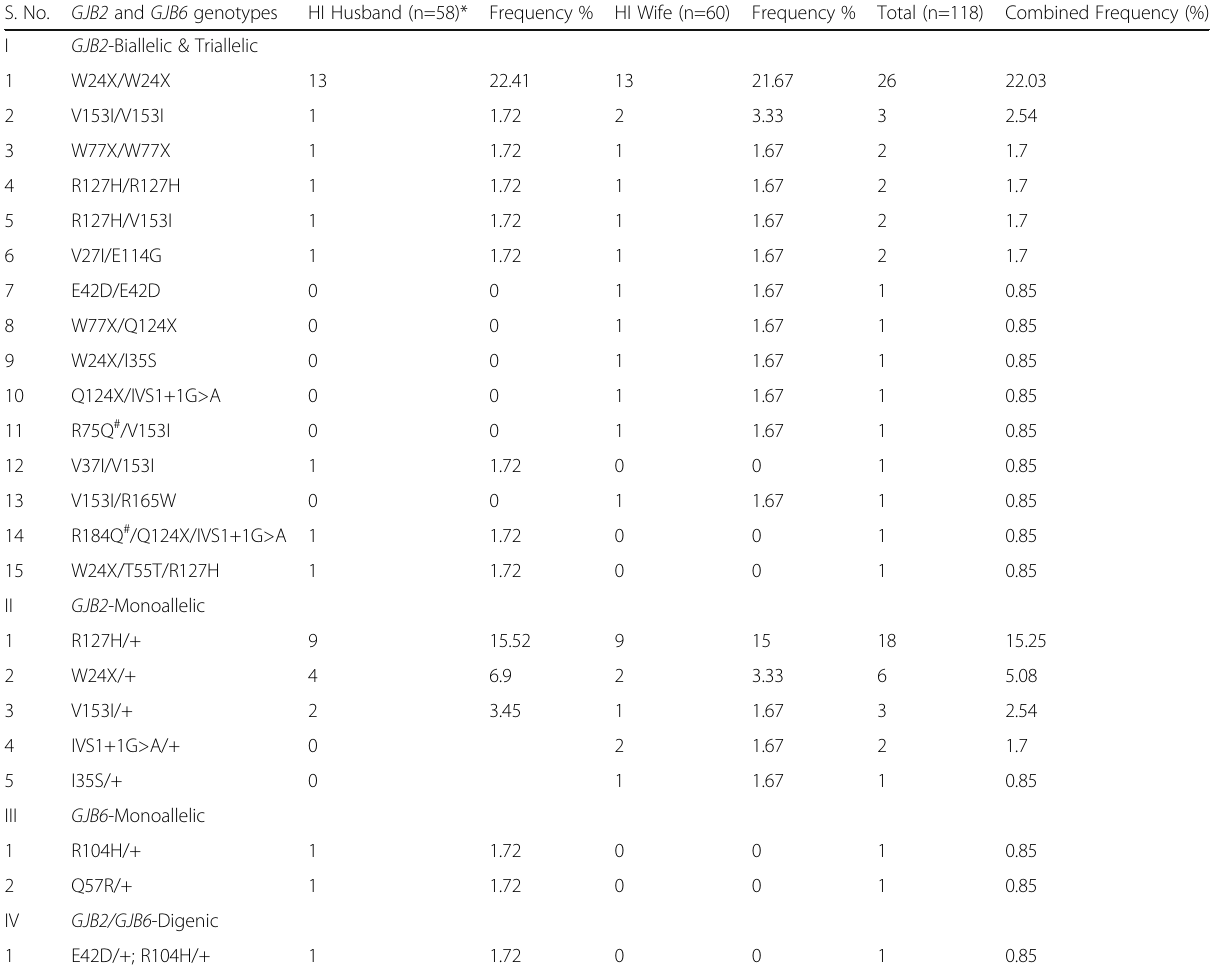
Table 8 Frequency and distribution of GJB2 and GJB6 genotypes observed among the 118 hearing impaired mates of DXD mating S. No. GJB2 and GJB6